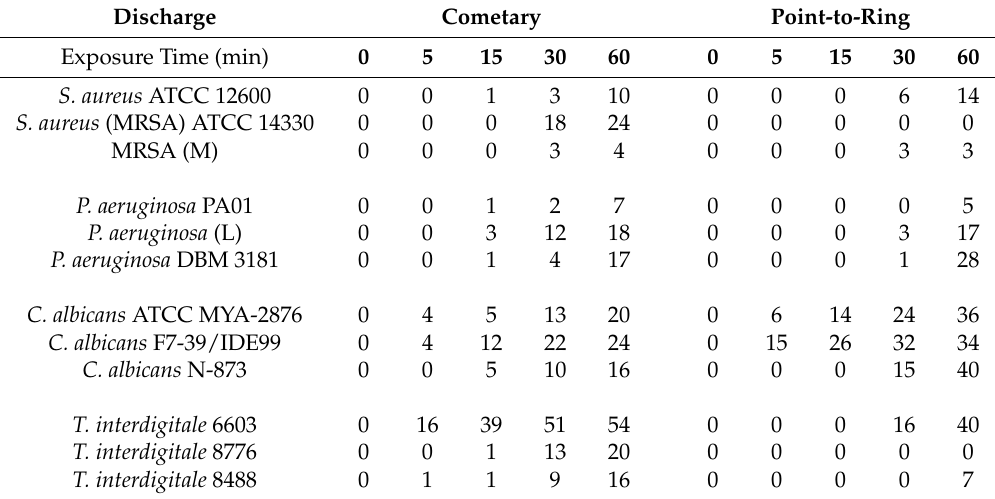
Table 2. Areas of complete inhibition (in cm 2 ) after exposure of individual microorganisms to the cometary/point-to-ring